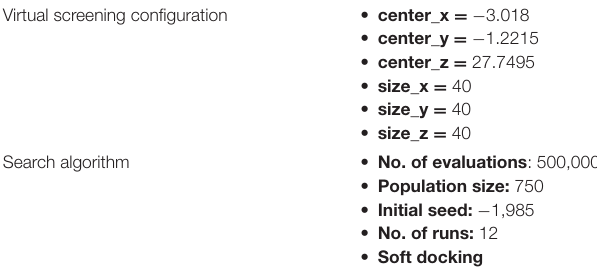
TABLE 2 | Blind docking simulation parameters and virtual screening configuration using Dockthor. Virtual screening